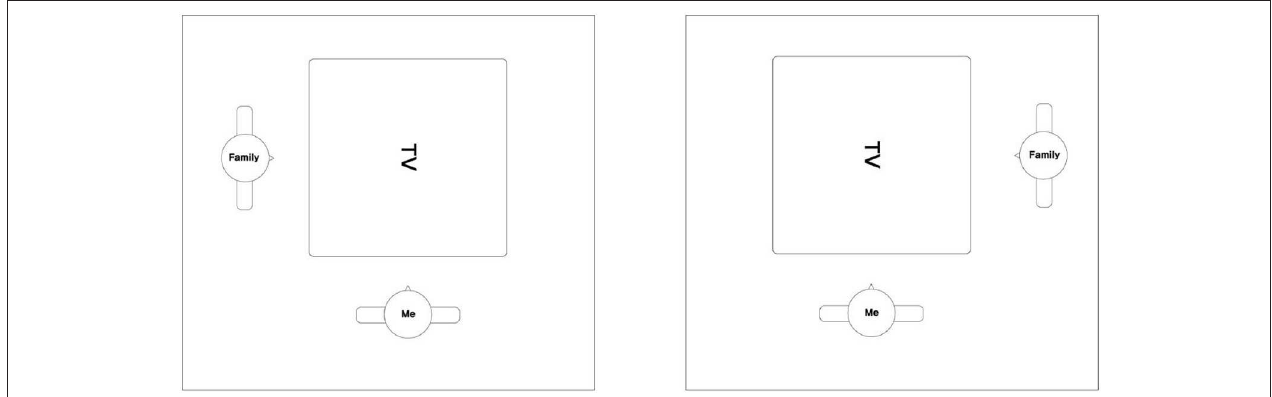
FIGURE 1 | Stimulus in Experiment 1. A stimulus word “TV” rotated 0 degrees from the other’s perspective in congruent condition (Left) and rotated 180 degrees from the affordance of the other’ perspective in incongruent condition (Right)